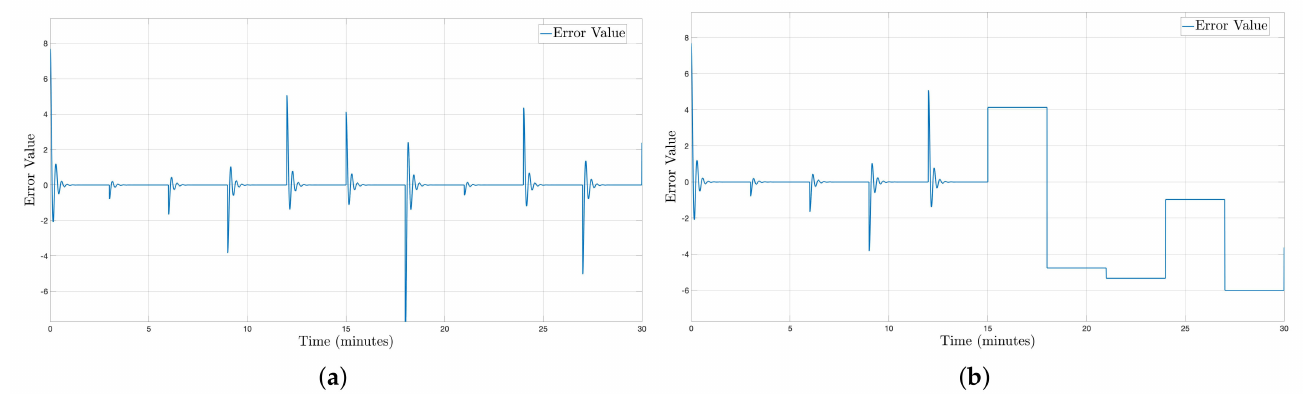
Figure 14. Error Values Under Regular and Attack. ( a ) Error Values Under Regular. ( b ) Error Values Under